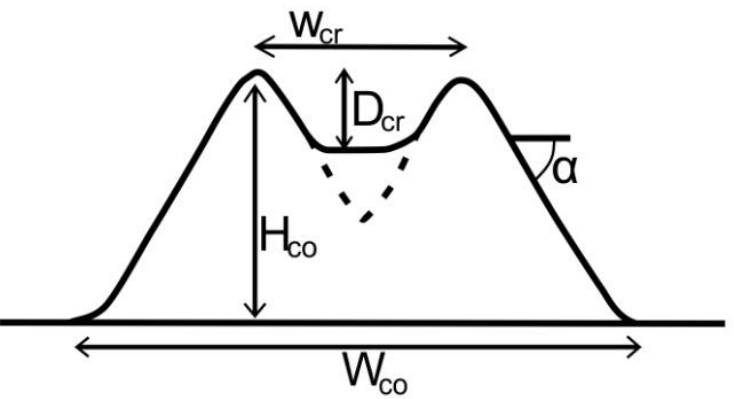
Figure 1. Relationships between volcanic parameters. W cr = crater width, D cr = crater depth, H co = cone height, W co = basal width of cone, α = maximum slope angle (based on [2]). One of the earliest studies was Colton’s [17] classic account of scoria cone morphology in the San Francisco Volcanic Field, Arizona. He classified them into five degradation stages of cones and basaltic flows on the basis of weathering. Scott and Trask [18] studied the morphologic, morphometric, chemical, and radiometric data of scoria cones and lava flows in the Lunar Crater volcanic field, Nevada: using maximum cone slope and cone width/cone height ratio, they derived relative morphologic ages for 15 cones. Settle [19] examined parameters of six volcanic areas (Mauna Kea (Hawaii), Mount Etna (Italy), Kili- manjaro (Tanzania), San Francisco Volcanic Field (Arizona), Paricut í n (Mexico), Nunivak Island (Alaska)), including average volume, cone height and diameter. One of the most significant works in scoria cone morphometry came from Wood ([3,4]) who considered cones of the San Francisco Volcanic Field, which had been categorized by Colton [17] and Moore and Wolfe [20] into age groups. Wood examined and compared these and observed trends that were also found in five other scoria cone fields (Lunar Crater Volcanic Field (Nevada), Newberry volcano (Oregon), Wu-ta-lien-chi volcano (Manchuria), Etna (Italy), and Piton de la Fournaise (R é union)) to determine if the degradation values are common to other scoria cone areas on Earth. Wood noted that (geological) maps did not provide adequate information for sufficient resolution of certain parameters (e.g., crater diameter). He claimed that the cone height ( H co ), height-to-diameter ( W co ) ratio, and slope angles ( α